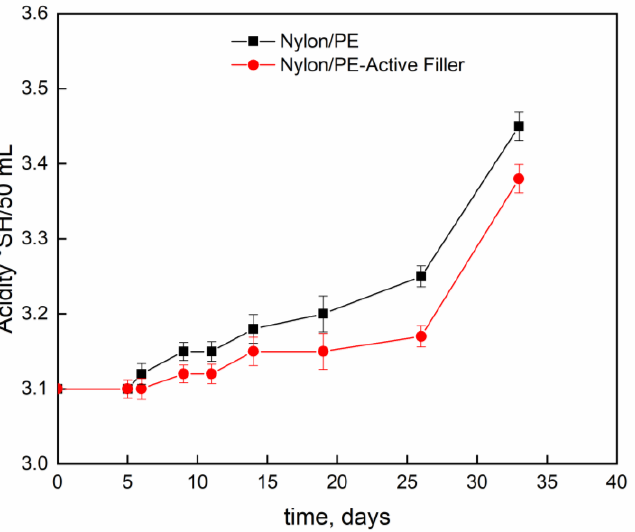
Figure 5. Evolution of acidity index (°SH/mL) as function of time, of milk stored at 4 °C into Ny- lon/PE and Nylon/PE-Active Filler pouches. Nylon/PE and Nylon/PE-Active Filler